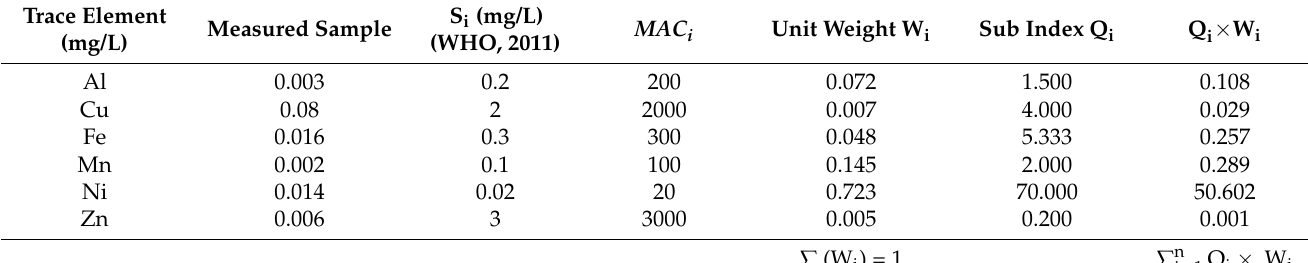
Table 3. The HPI, C d , and PI are computed using an arithmetic rating